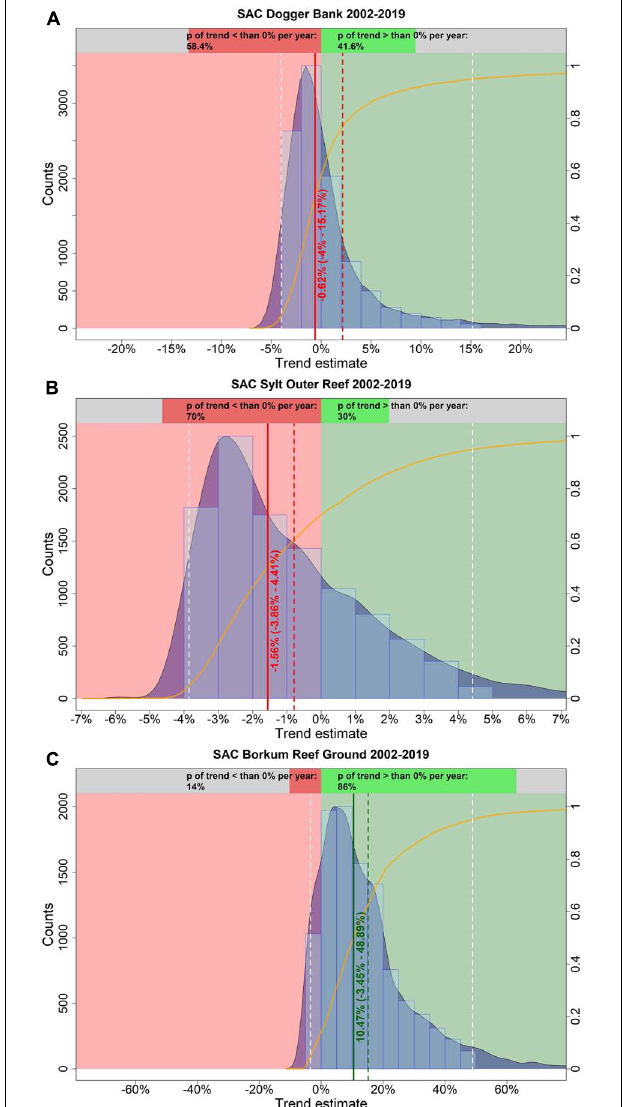
FIGURE 8 | Estimated trends in harbour porpoise abundance in the three SACs Dogger Bank (A) , Sylt Outer Reef (B) , and Borkum Reef Ground (C) in spring, between 2002 and 2019. The light blue histogram and the blue shaded density curve show the distribution of the trend estimates (relative change in abundance) between 2002 and 2019 ( x -axis); the median is indicated by the solid red vertical line. The mean is shown by the vertical red dashed line, while the white dashed lines represent the upper and lower 95% credibility intervals of the trend estimate. The red coloured area corresponds to an area with a negative trend, whereas the green coloured area represents a positive trend. The orange solid line illustrates the empirical cumulative distribution function of the trend estimates, giving the probability of a trend estimate at a specified value (e.g. 0%). The upper bar chart hence indicates how likely it is that the trend is either negative (i.e., p < 0%; red) or positive (i.e., p > 0%;